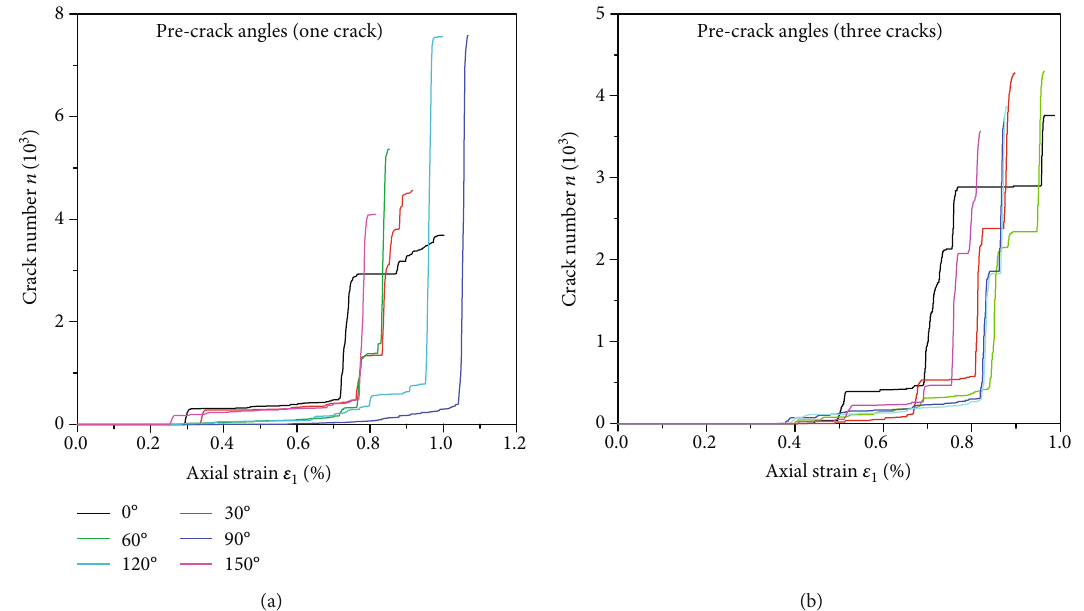
Figure 14: Crack number evolution of the precracked sandstone specimens: (a) crack number evolution of the specimens containing a single precrack; (b) crack number evolution of the specimens containing three precracks.